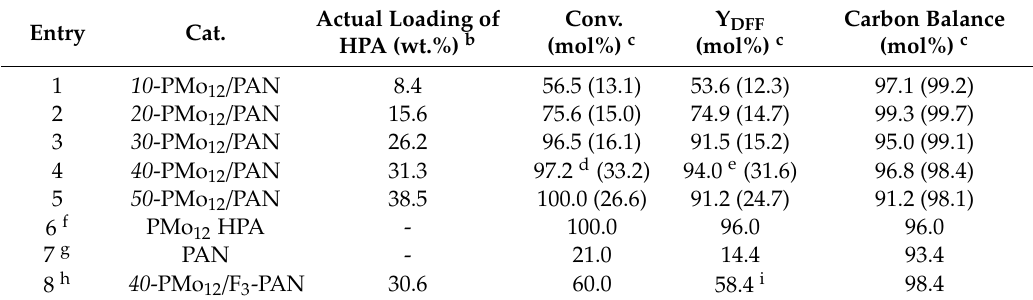
Figure 2. SEM/EDX-mapping of the 40 -PMo 12 /PAN catalyst. ( a ) SEM photo, ( b ) C element, ( c ) N element, ( d ) O element, ( e ) P element, and ( f ) Mo element.